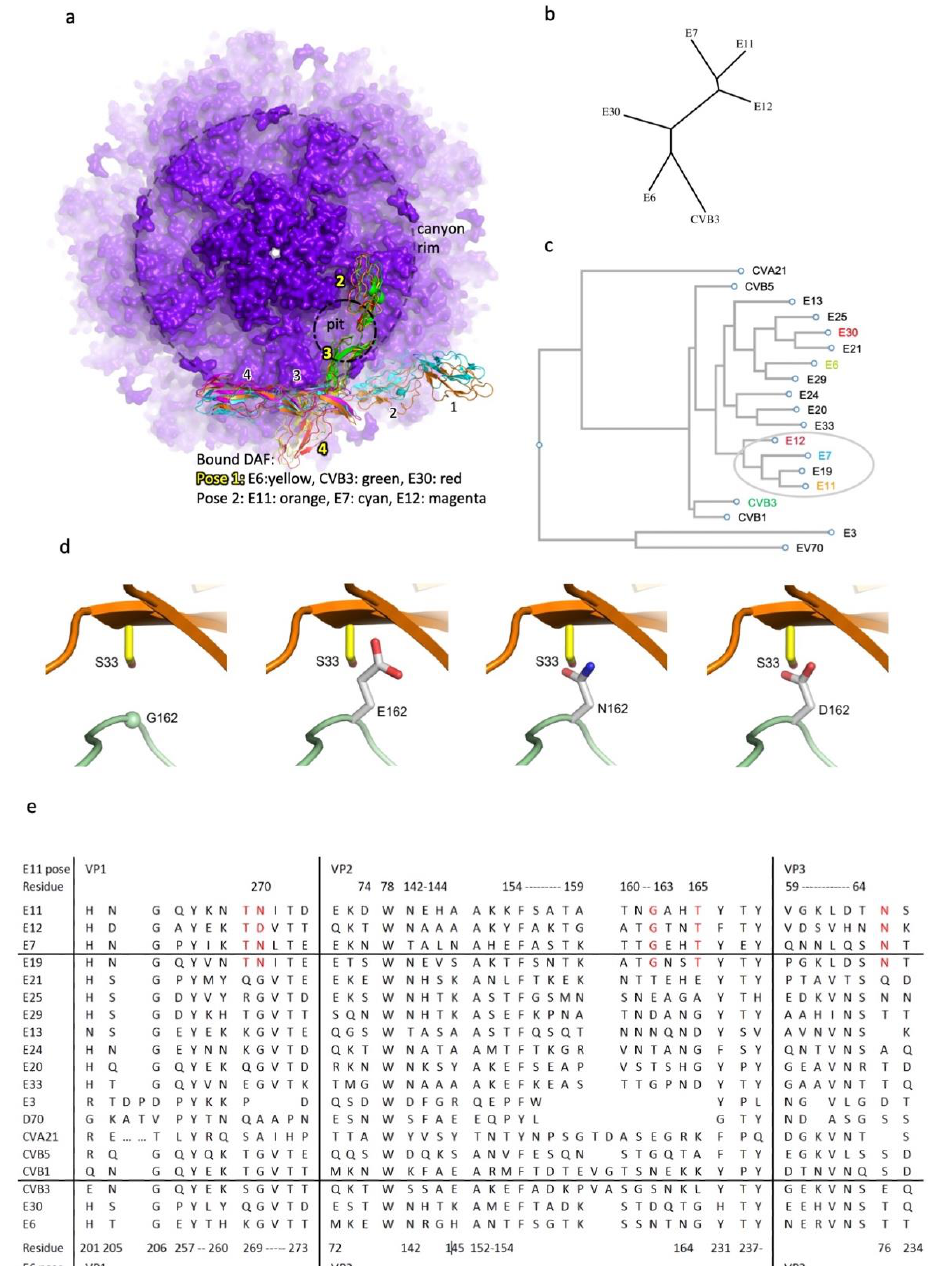
Figure 3. Binding mode of DAF. ( a ) Two different binding patterns of DAF with different en- teroviruses. The viral capsid is shown as surface representation, one pit region in the canyon region of the capsid is marked by a dashed circle and the outer rim of the canyon is marked by a larger dashed circle. DAF molecules are shown in cartoon representation with different colors indicating the different viruses they bound with (green: CVB3, PDB: 7VY5; yellow: E6, PDB:6ILK; red: E30, PDB:7C9W; cyan: E7, PDB:3IYP; orange: E11, structure in this paper; magenta: E12, PDB:1UPN). ( b ) Phylogenetic tree of 6 DAF binding enteroviruses based on the capsid structures. ( c ) Phylogenetic tree of 20 DAF-binding enteroviruses based on the capsid sequences (colours as in (a)). ( d ) Substi- tutions of VP2 G162 ( left panel in green) conserved in viruses with E11 DAF binding mode with D/N/E (second to forth panel, respectively) found in viruses with E6 DAF binding mode would clash with S33 of DAF (orange). ( e ) Gene sequence alignment of 20 DAF-binding enteroviruses. Key residues for the E11 and E6 interactions are listed above and below the sequence alignment, respectively and those marked in red are conserved among E11 pose enteroviruses and